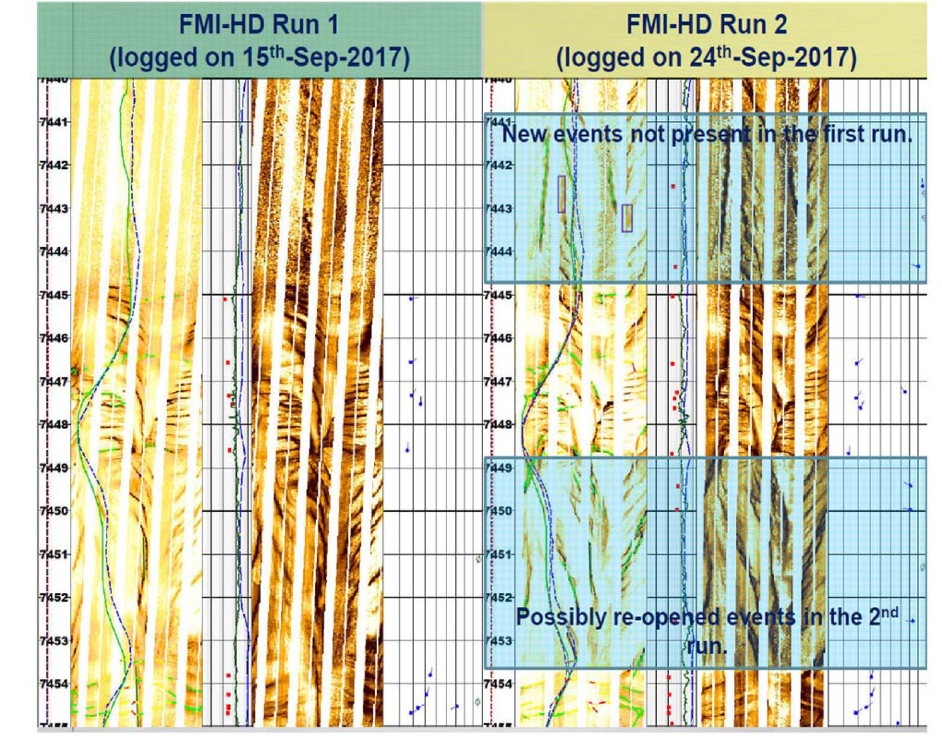
Fig. 5 A snapshot of the Forma- tion MicroImager (FMI) log acquired from both runs, before and after the DFIT testing. This snapshot just shows a small section of the openhole. This is a multi-pad resistivity tool that provides a high-resolution reconstruction of the wellbore, highlighting compositional changes, porosity, breakouts and fracturing through resistivity contrast. To the right of each log are the dips and